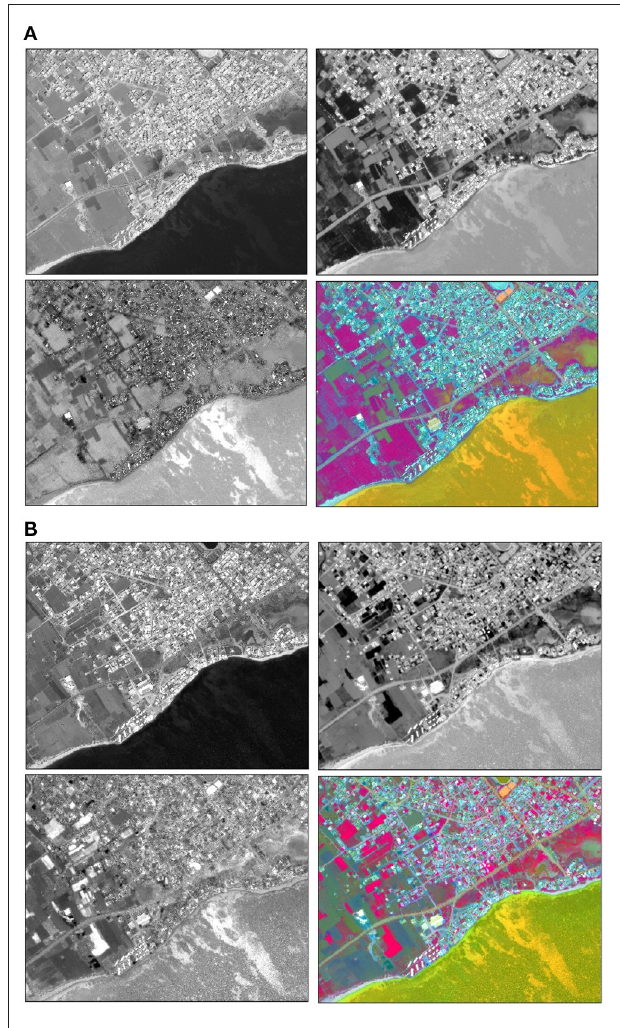
FIGURE 2 | (A) The first three PCA component (image in gray tones) and the RGB (RED GREEN BLUE) composite image (PCA1/PCA2/PCA3) of 2012. (B) The first three PCA component (image in gray tones) and the RGB (RED GREEN BLUE) composite image (PCA1/PCA2/PCA3) of 2012. In both cases (A,B) , the second PCA (PCA2) shows an evident spectral enhancement of the building expansion path. On the image this path is represented in white color. The RGB images represent the best information considering all elements of the image; Buildings are represented with indistinct color tones. Location sample is indicated by a red square in Figure 1